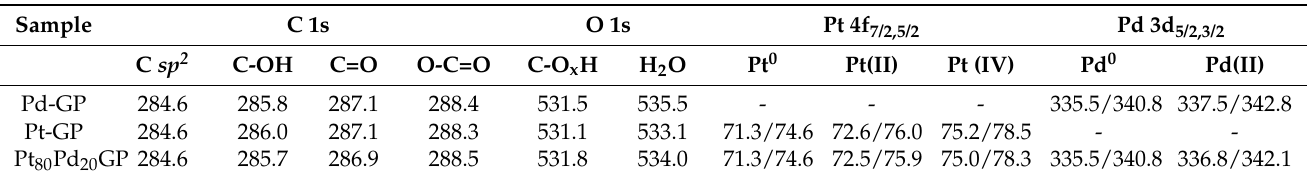
Table 1. Position (Binding Energy/eV) of the peak components used in the deconvolution of the spectra reported in Figures 5 and 6.